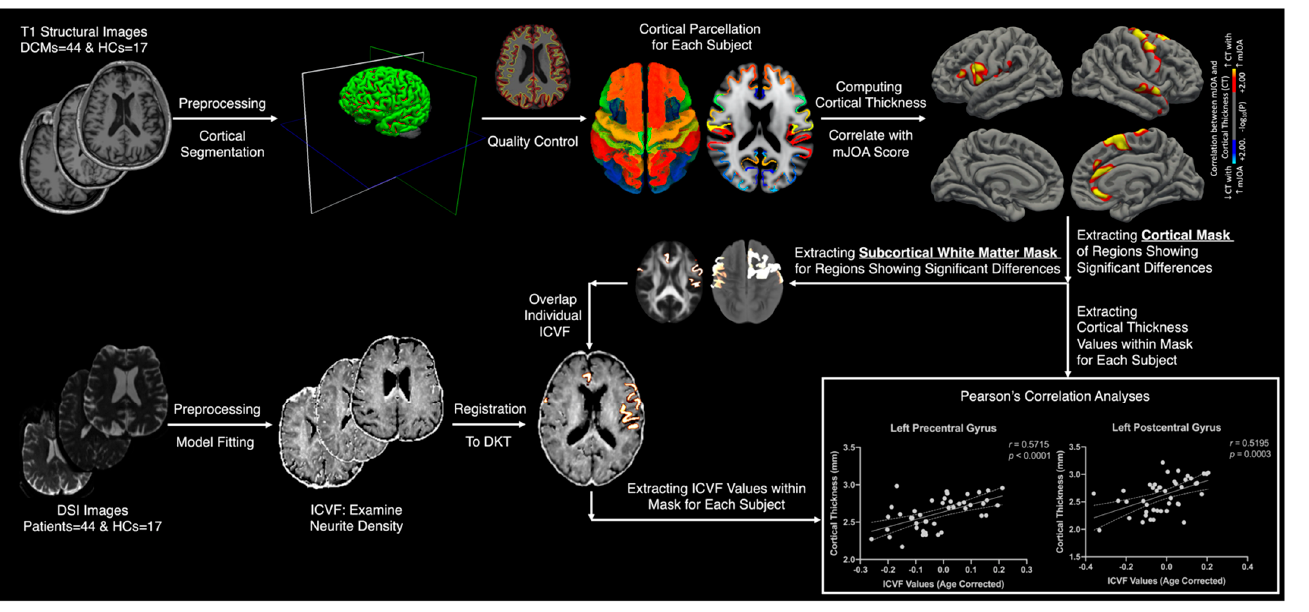
Figure 1. Image processing and analysis pipeline. Followed by the preprocessing of T1-weighted structural images, regions showing significant association between the cortical thickness and mJOA scores were identified. Average cortical thickness of those regions and subcortical white matter masks below those regions were extracted. Followed by the preprocessing of diffusion-weighted images, ICVF brain maps of each subject were extracted. Subcortical white matter masks of ROIs were superimposed on ICVF brain maps to extract regional ICVF values, which were used in further statistical analyses.